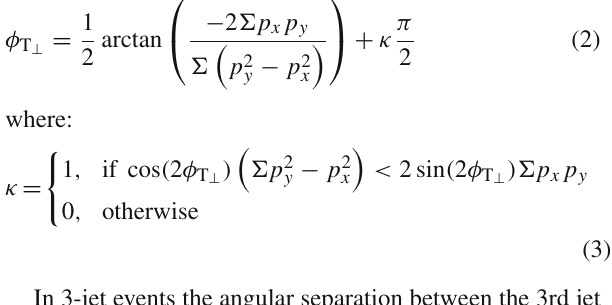
lower yield of soft 3rd jet. Powheg and Madgraph tributions look similar.